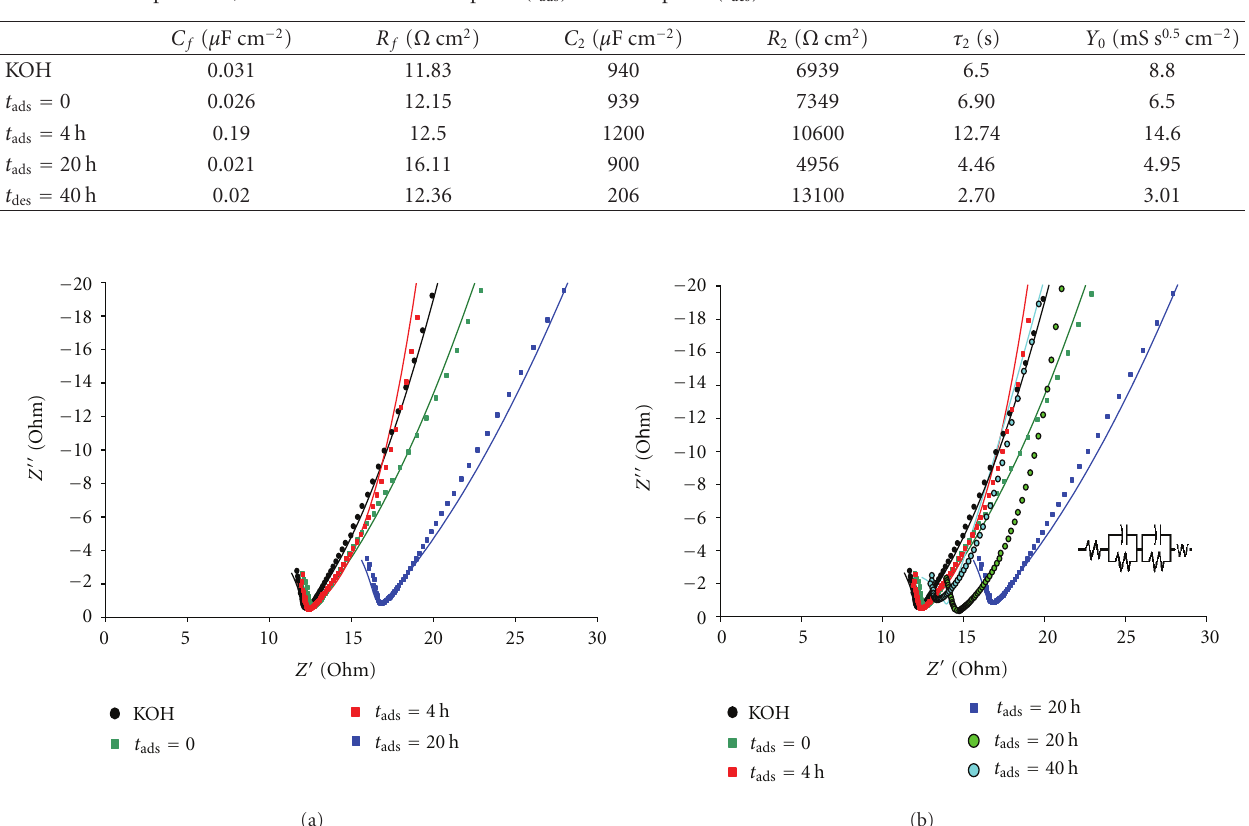
Table 5: Circuit parameters obtained by fitting the experimental impedance results with the selected equivalent circuit. Data obtained in the dark at the OCV potential, as a function of the adsorption ( t ads ) and desorption ( t des ) times.